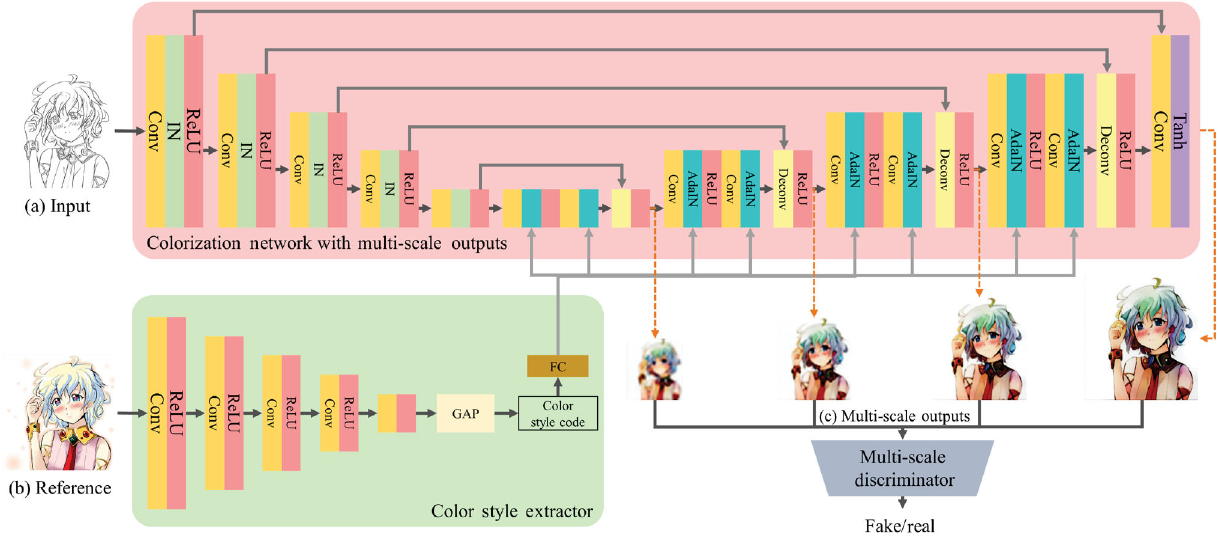
Fig. 2 Overview. Our framework takes an input image (a) and a reference image (b) as input, and outputs a color cartoon (c) that is consistent with the input in content and consistent with the reference in